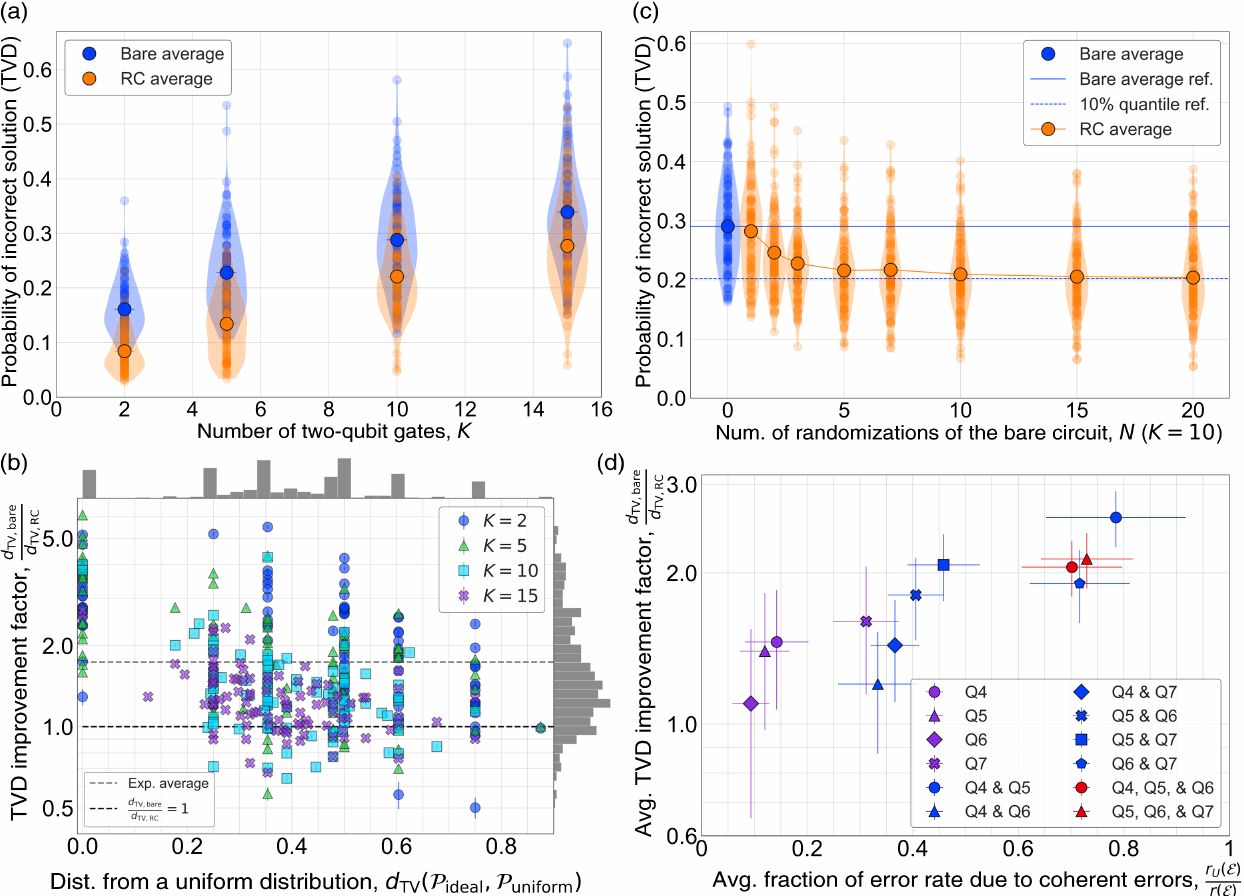
FIG. 4. Randomized compiling extends the computational reach with respect to circuit depth. (a) Bare and RC TVDs as a function of circuit depth K . RC reduces the TVD on average for all circuit depths tested, allowing one to perform longer gate sequences under a fixed TVD error budget. The semitransparent blue (orange) points indicate the TVDs of the individual random circuits (the unioned data over all N ¼ 20 randomizations of the corresponding bare circuits). Violin plots depict the distribution of results. The TVD error grows approximately linearly with K for both bare and RC results, suggesting that the dominant reason for an improvement under RC is an overall reduction in the error for each gate cycle K , rather than a suppression of the adversarial accumulation of coherent errors (although RC can additionally provide this benefit). (b) RC TVD improvement factor for the random circuits in panel (a) as a function of =d ≈ 1 . 7 . (c) TVD as a function of number of randomizations, with distribution uniformity. The average improvement is d TV ; bare TV ; RC K ¼ 10 fixed. The average TVD under RC converges to a value close to the 10% quantile level (dashed line) of the nonrandomized circuits for N ¼ 20 . However, only N ¼ 10 randomizations are needed to converge to within 2.7% of the N ¼ 20 level. (d) For a fixed total error rate, RC provides a larger TVD improvement for systems with a higher fraction of coherent errors. The colored subsets listed in the legend highlight random single-qubit circuits that were performed in isolation (purple) or in parallel (blue and red). The average fraction of the total error rate due to coherent errors was quantified using measurements of RB and unitary RB under isolated or simultaneous